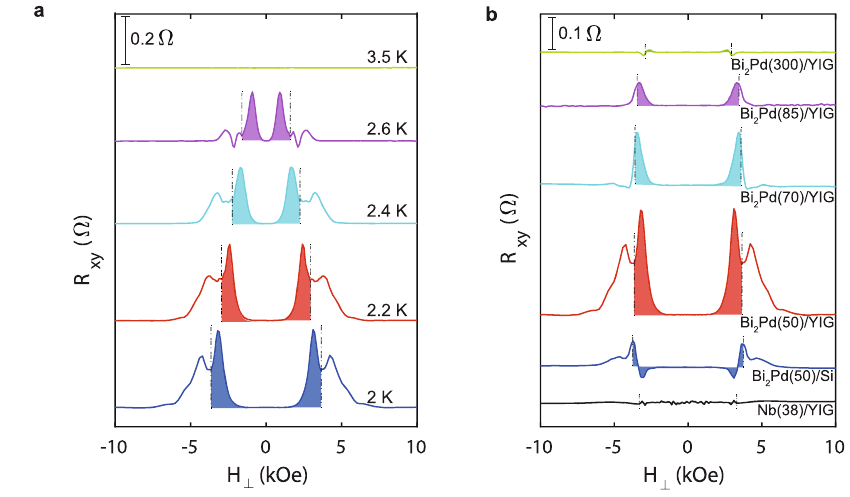
Fig. 2 | Transverse resistance, R xy , (with arbitrary offsets for clarity) as a functionofmagnetic fi eld.a R xy atvarioustemperaturesfor50nmBi 2 Pd/YIG fi lm. b R xy forBi 2 Pd/YIG fi lmswith differentthicknesses(50nm, 70nm,85nm, 300nm, respectively) in comparison with 50 nm β - Bi 2 Pd/Si and 38 nm Nb/YIG. In order to comparetheresultsobtainedfromthesampleswithvarious T c ,thetemperaturesat which the measurements are conducted are selected so that H c2 remains similar